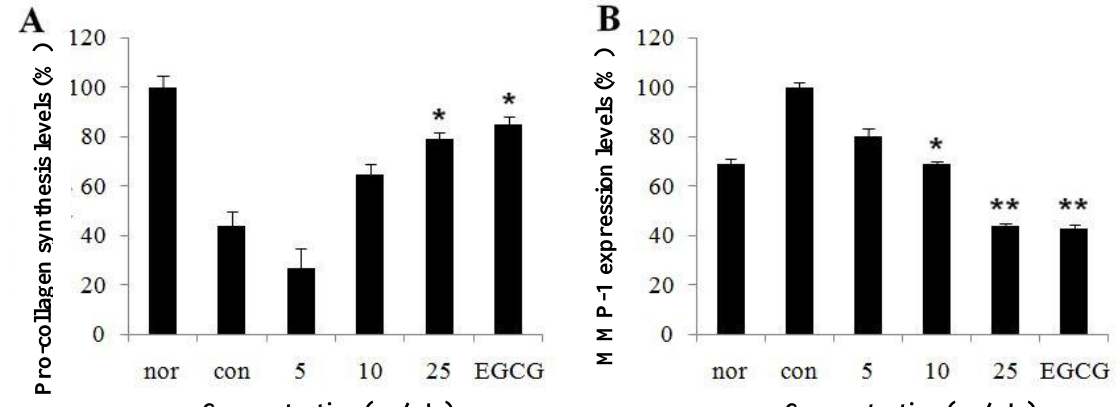
Figure 2. ( A ) Type-I procollagen synthesis and ( B ) MMP-1 inhibition of fibroblast CCD-986sk cells after CopA3 treatment. Fibroblast cells were exposed to UVB for 1 min and treated with various concentrations of CopA3. Type-I procollagen synthesis and MMP-1 inhibition were measured with an assay kit. All experiments were performed in triplicate. Values shown are means ± SEM ( n = 3). * p < 0.05; ** p < 0.01 versus the control group. EGCG was used at 25